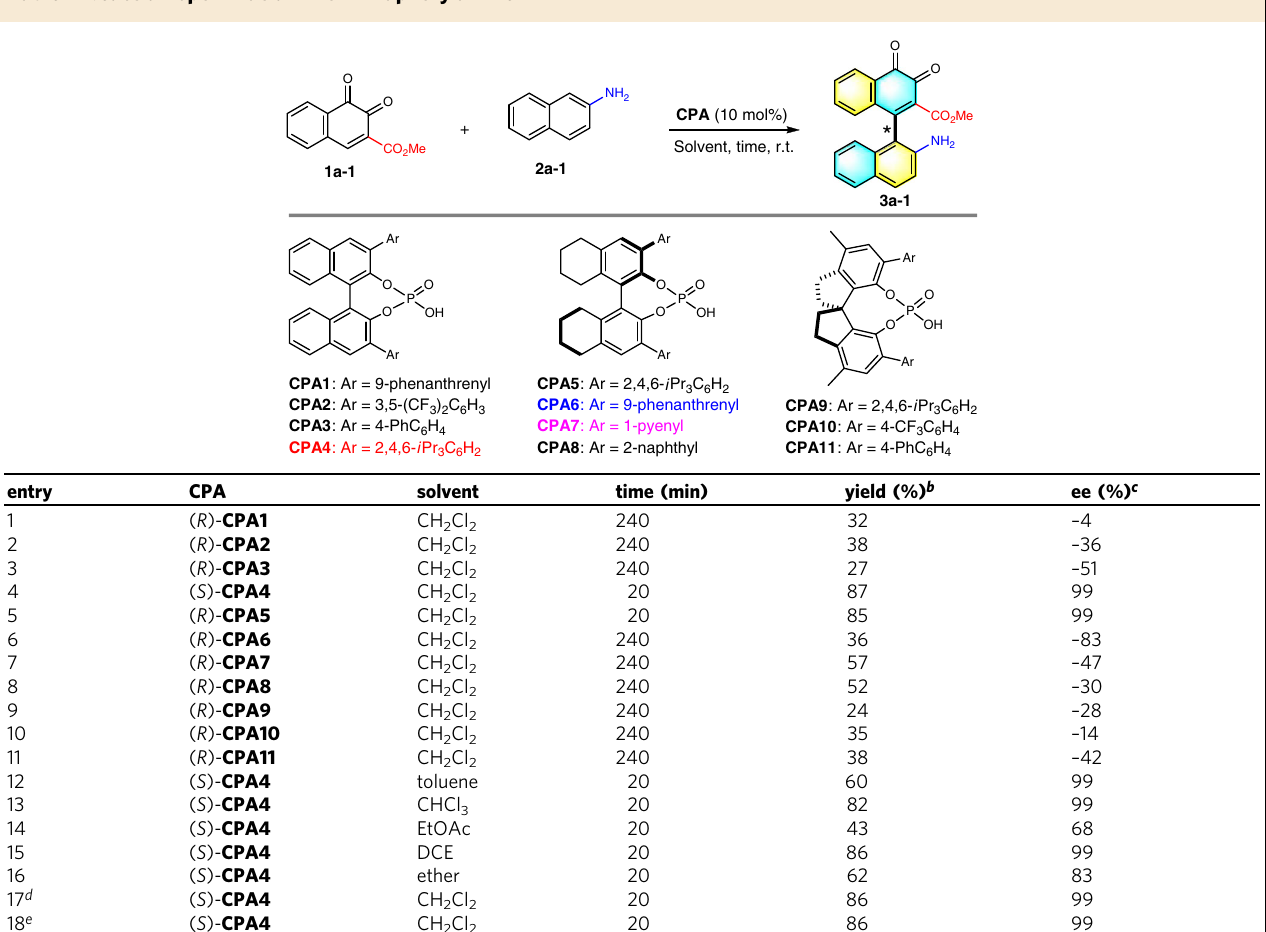
Table 1 Reaction optimization with 2-naphthylamine a